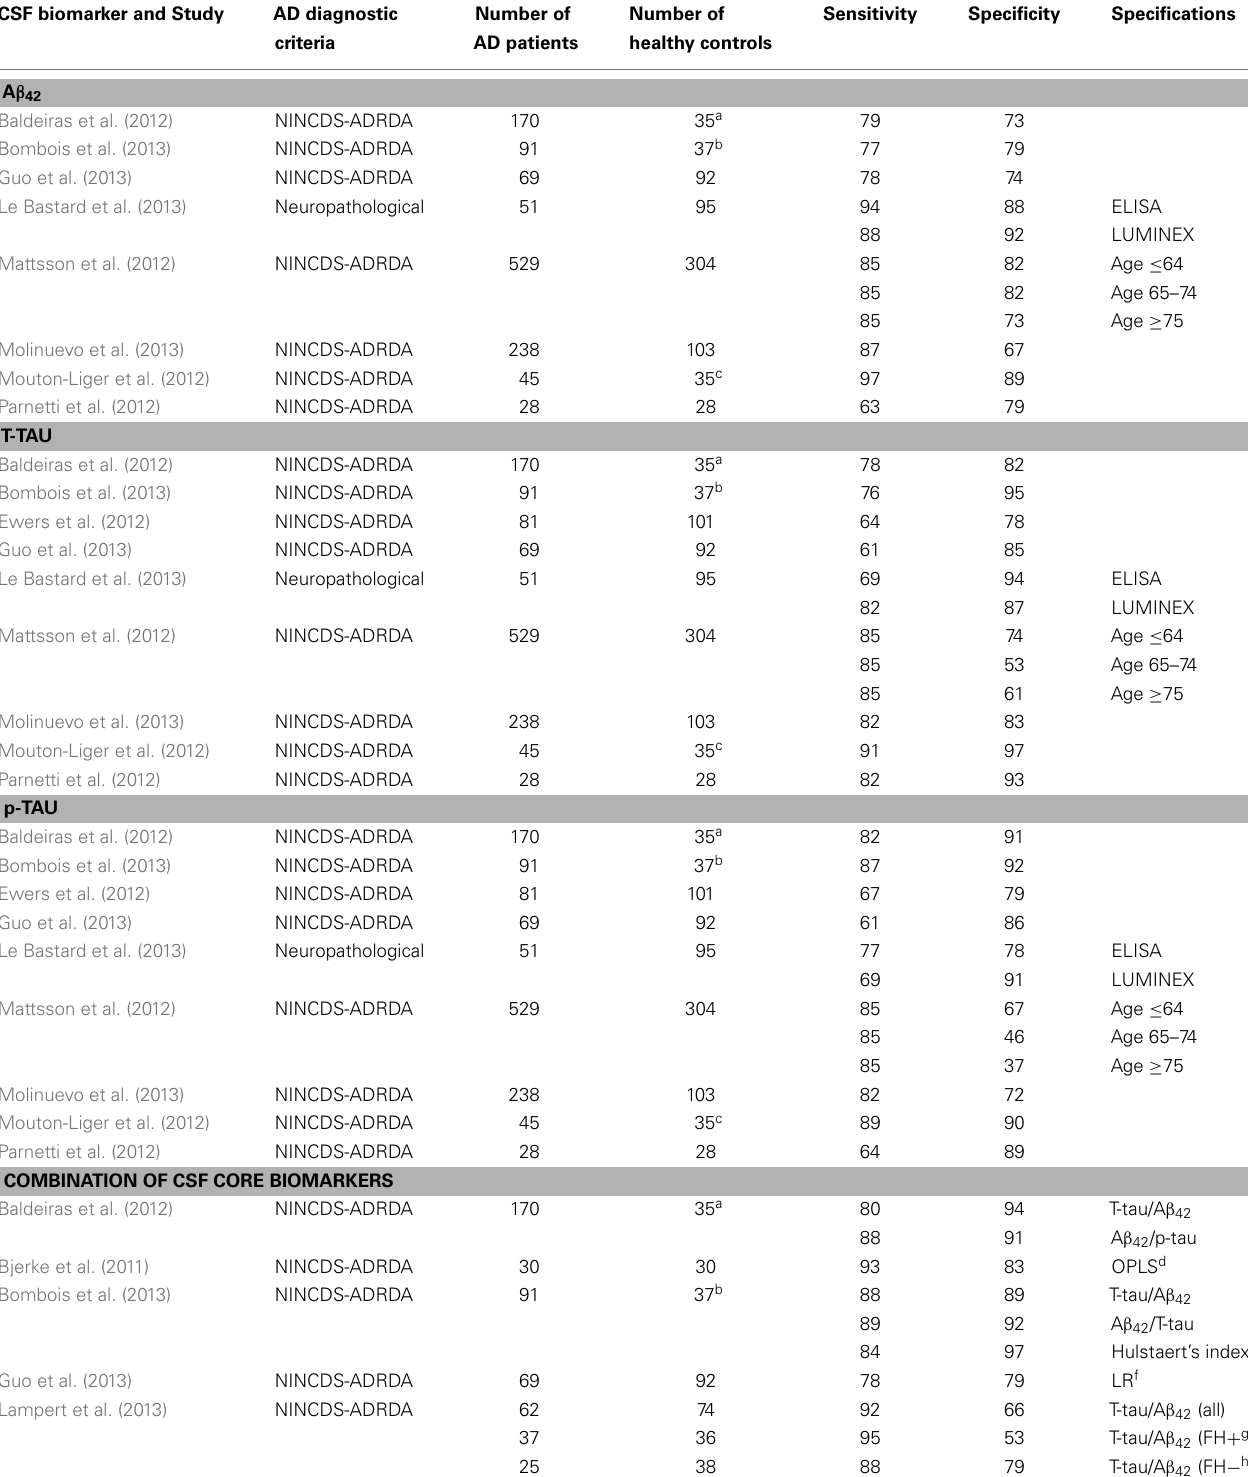
Table 6 | Primary studies published after the new revised diagnostic criteria (AD vs. Healthy Controls): sensitivity and specificity